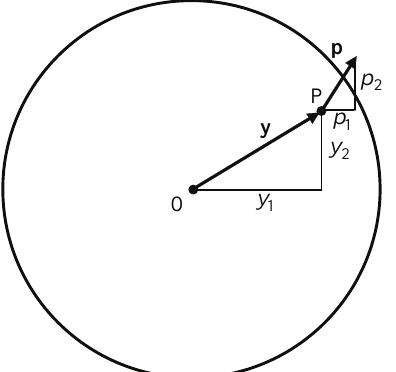
Figure 2. A thin lens is viewed along its axis. Point P on a thin lens has position vector y with respect to the optical centre O of the lens. It has horizontal and vertical components y spectively. The deflection or prismatic effect at P is represented by vector p with components p lel to the longitudinal axis would emerge with inclination p . In Figure 4 p is perpendicular to y and points in a clockwise sense about